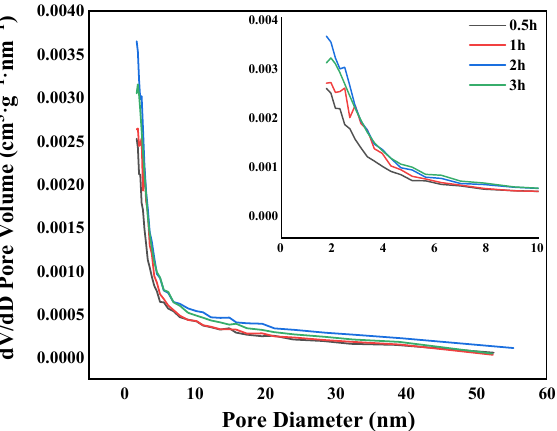
Figure 2. Pore-size distribution of coke and CO 2 under different melting-loss time.